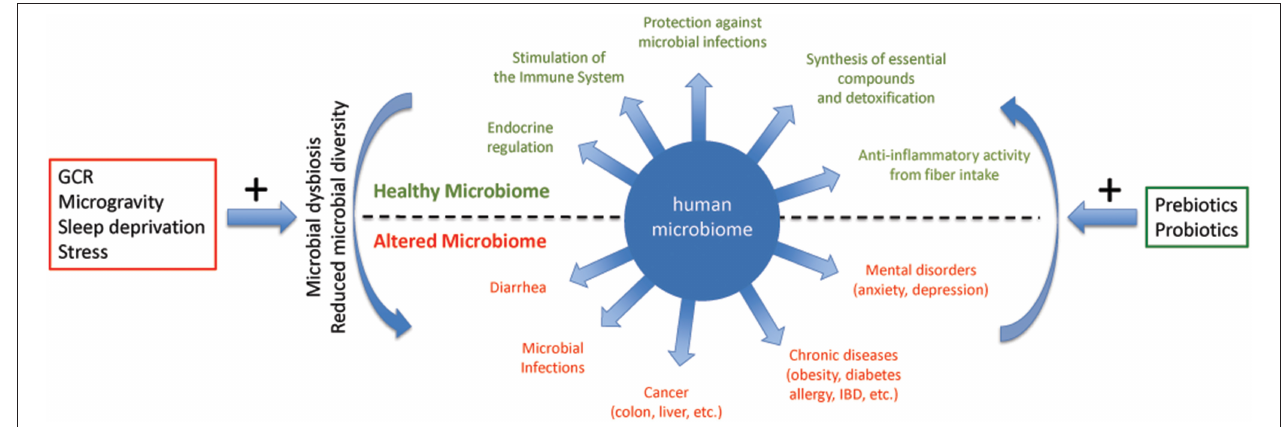
FIGURE 1 | Effects of space travel on the human microbiome. Stressors associated with space travel (red box) may disrupt the composition of the human microbiome causing dysbiosis. Microbial imbalance could result in the loss of some of its beneficial effects on human health (green) increasing the risk of astronauts of contracting infection or developing human diseases (red). Prophylactic treatments with prebiotics or probiotics (green box) could be used to counterbalance the detrimental effects of space travel on the astronauts’